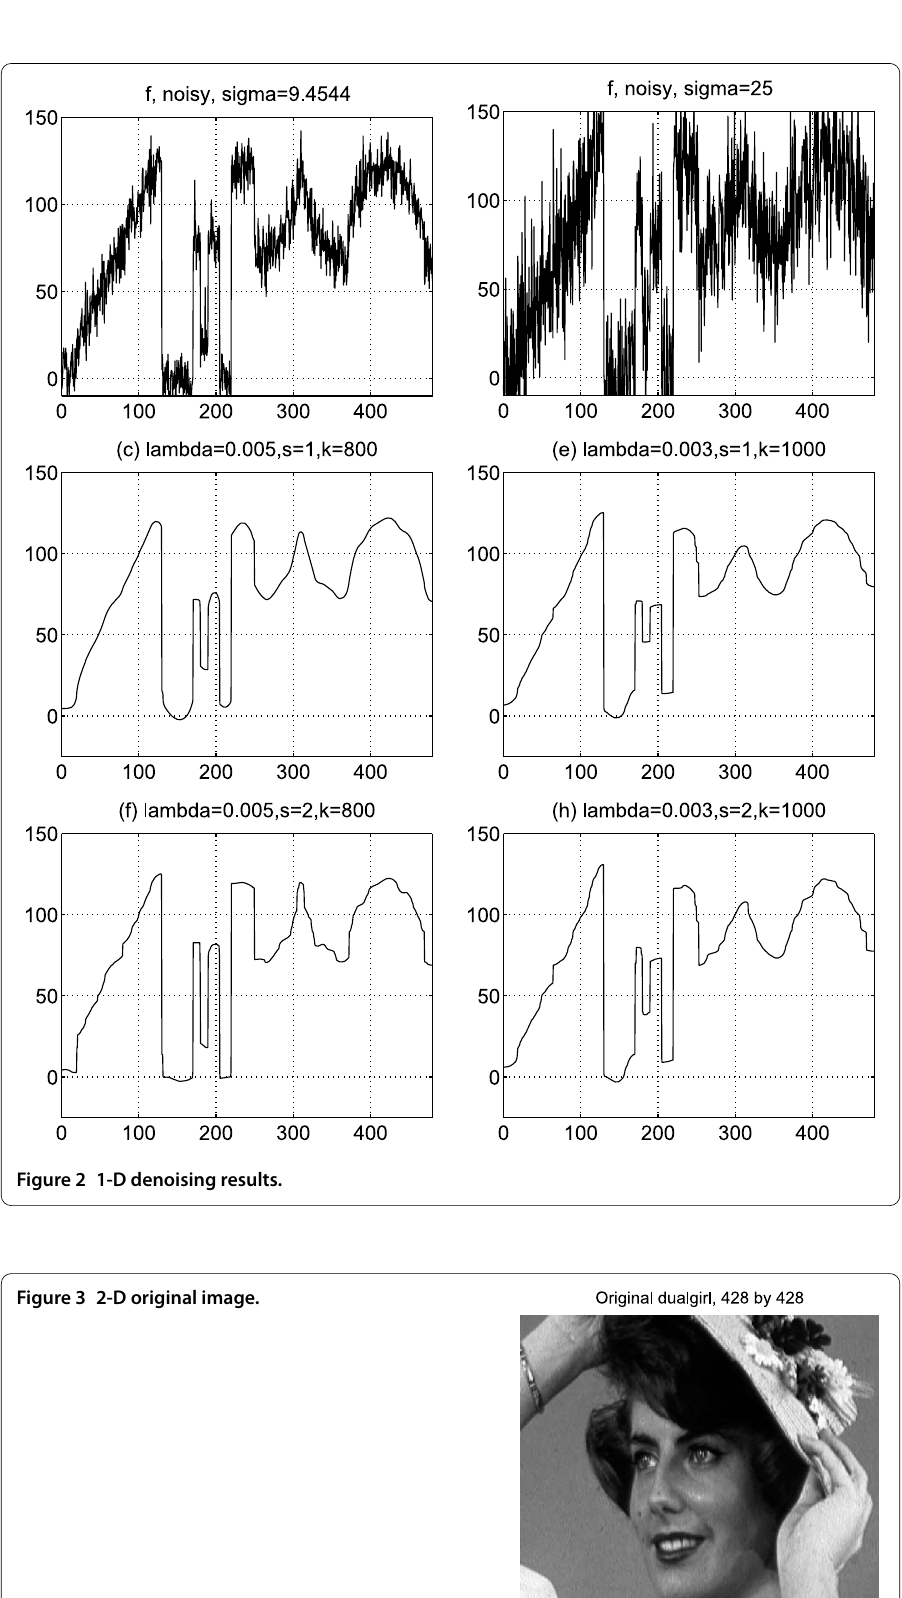
Figure 3 2-D original